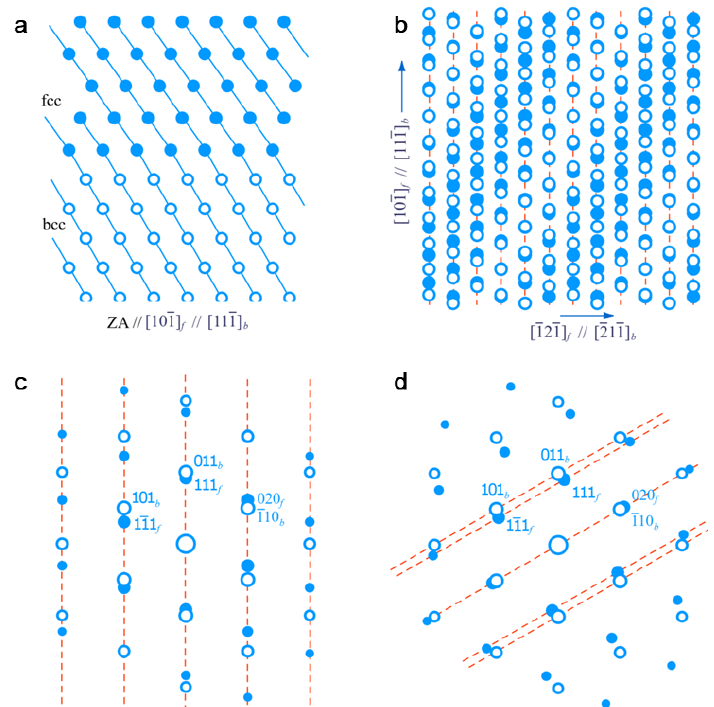
Figure 4. The atomic row matching in the (111) f //(011) b interface at the K–S orientation relationship (OR) for an face centered cubic/body centered cubic (fcc/bcc) system with λ = 4/3. ( a ) Atomic matching viewed from the [10−1] f //[11−1] b direction with interface edge-on. ( b ) Atomic row matching at the (111) f //(011) b interface layer. ( c ) Simulated diffraction pattern of ( a ). ( d ) Alignment of (020) f and ( − 110) b by rotating 5.26 ◦ from ( c ) to Pitsch OR.